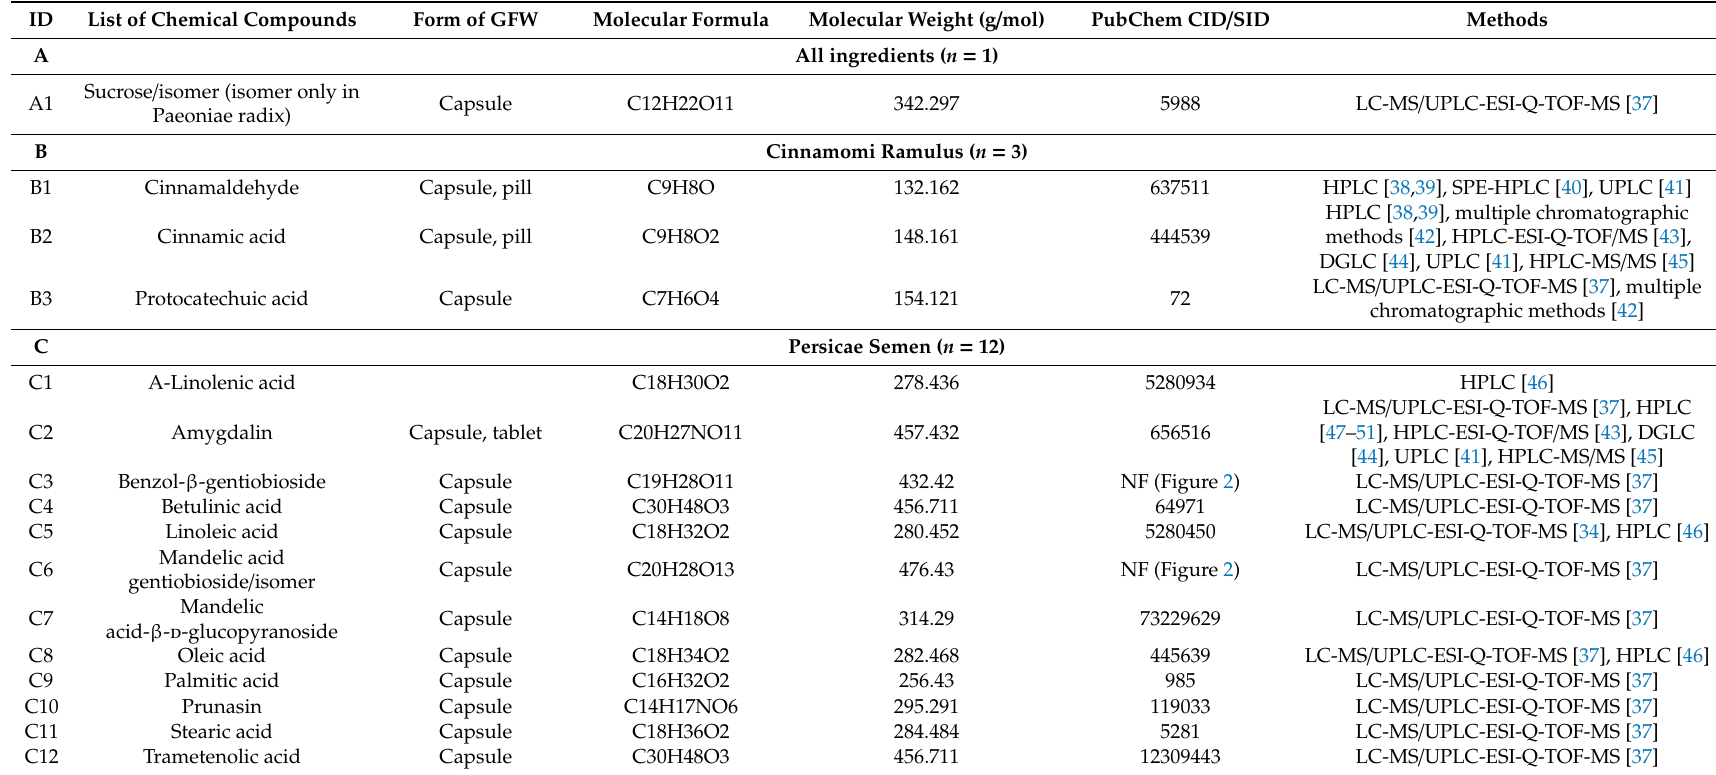
Table 2. Chemical compounds from Guizhi Fuling